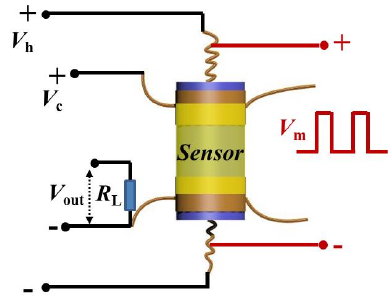
Figure 1. Schematic diagram of the gas sensor with electric modulation voltage.